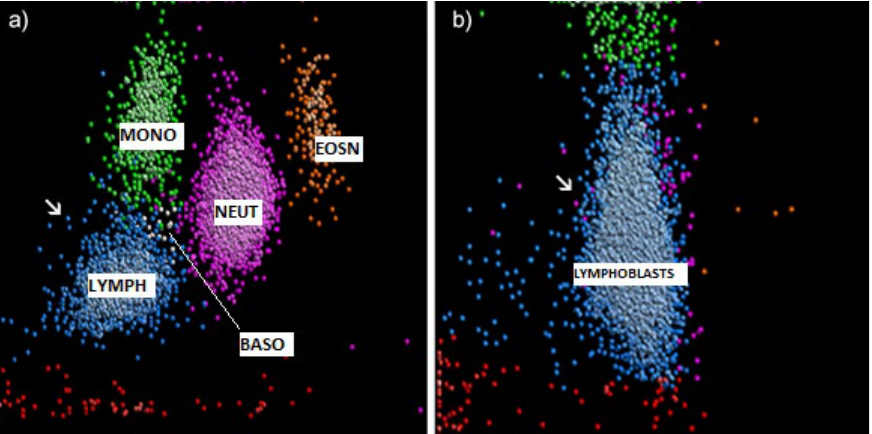
Figure 1. ( a ) Volume CPD presentation of a normal case. Blue population represents the lymphocytes (lymph), magenta population represents the neutrophils (neut), green population represents the monocyte, orange population represents the eosinophils and yellow population represents the basophils; ( b ) CPD (volume parameter) presentation of ALL cases. The area marked with white arrows on the blue population labelled as “lymphoblasts” shows the clearest distinction between the two cases, being the lymphoblast population in ALL cases. Supplementary S1 provides descriptions of the CPD parameters.